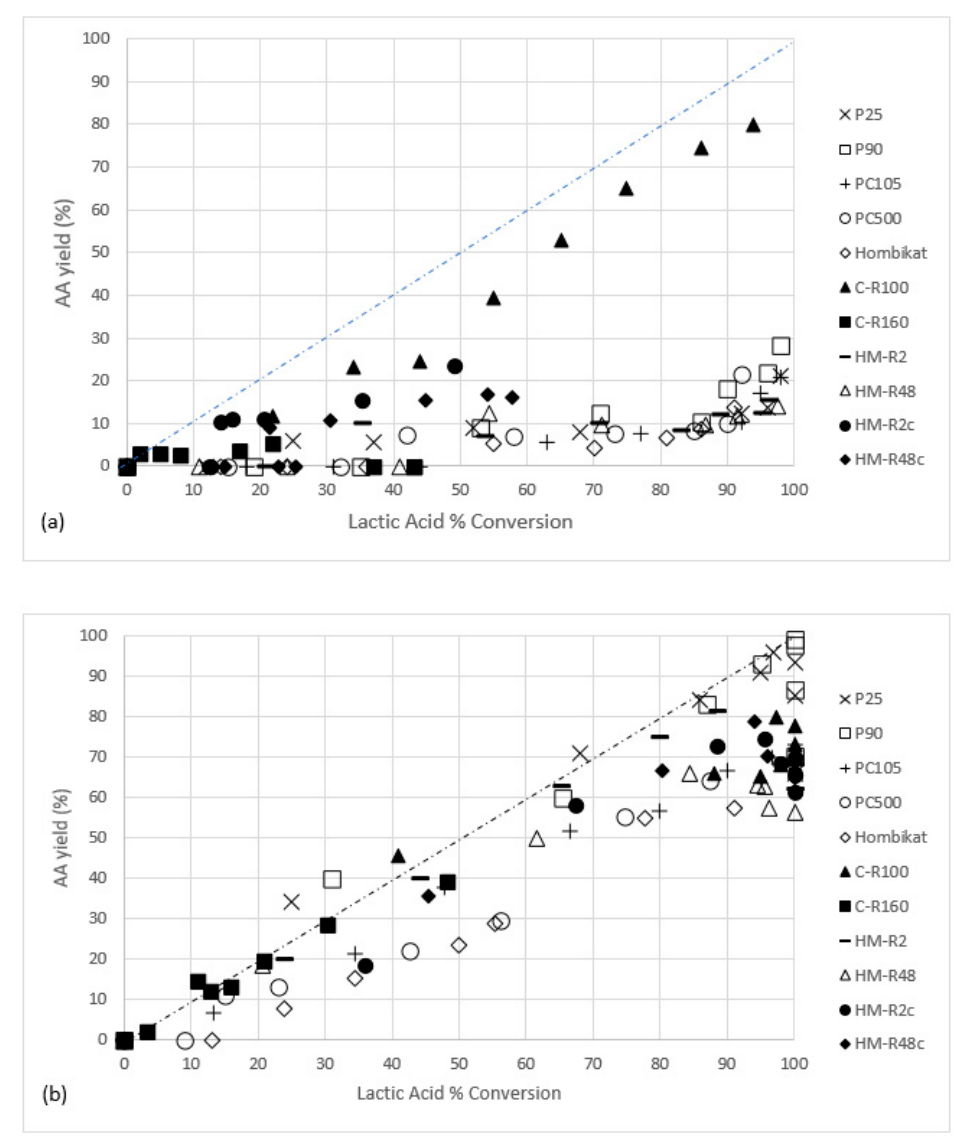
Figure 6. Acetic acid yield as a function of lactic acid conversion ( a ) without H 2 O 2 and ( b ) with H 2 O 2 in the presence of various catalysts. Dotted line corresponds to 100% of selectivity.